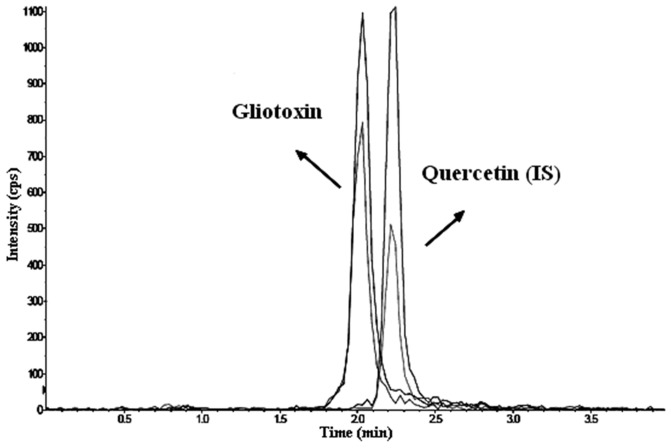
Representative HPLC-MS/MS chromatogram of human serum spiked with standards of gliotoxin and the internal standard quercetin.Ion transitions of gliotoxin: m/z 324.9→261.2 and m/z 324.9→243.1. Ion transitions of quercetin: m/z 300.8→151.0 and m/z 300.8→179.0.